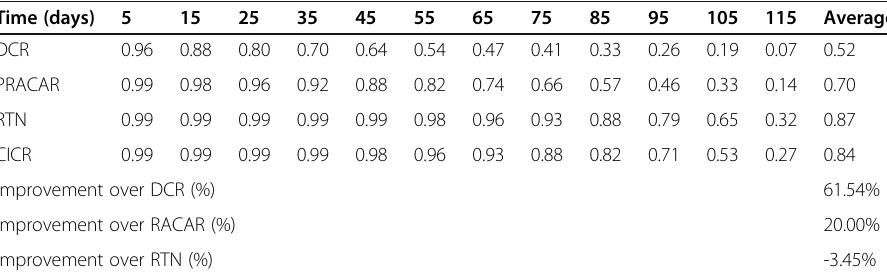
Table 4 Reliability of the restored region with four partitions versus time Time (days)